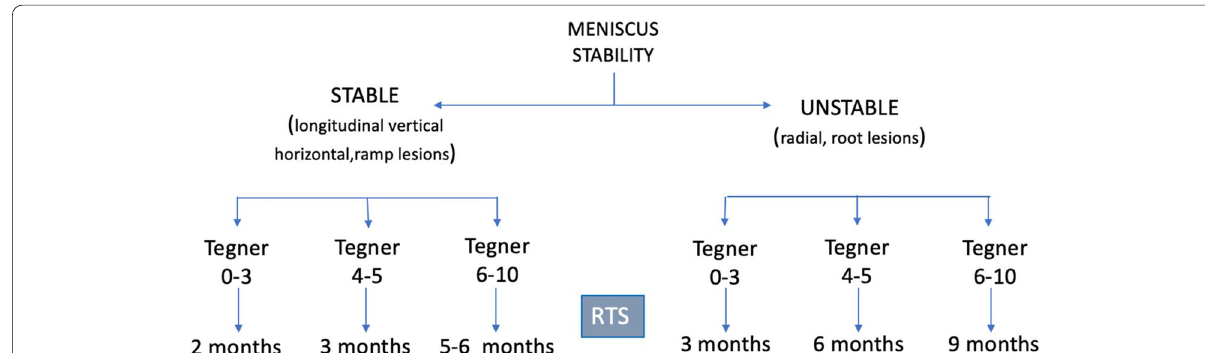
Fig. 2 A RTS protocol after isolated meniscal repair is developed and proposed by the authors in accordance with the Tegner Activity Scale and meniscus